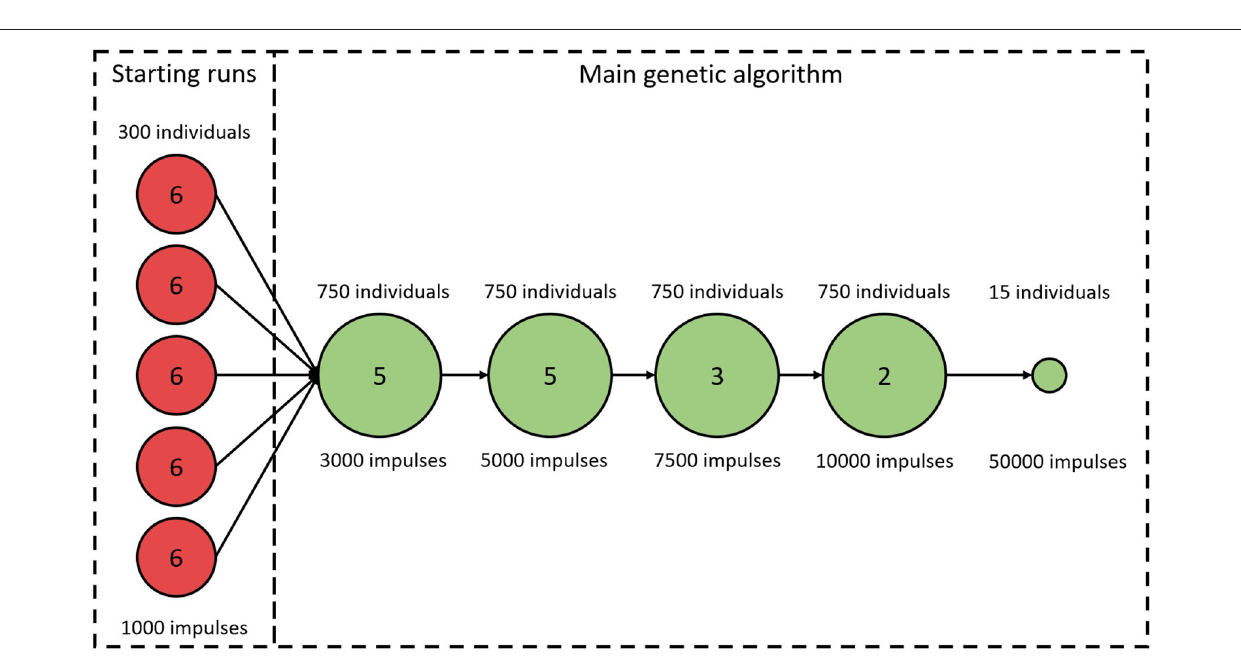
FIGURE 3 | A schematic representation of the genetic algorithm. Circles represent stages of the algorithm with constant number of individuals and L RR . Numbers in circles correspond to the number of iterations before proceeding to the next stage. The last stage is always used, even if the GA terminates